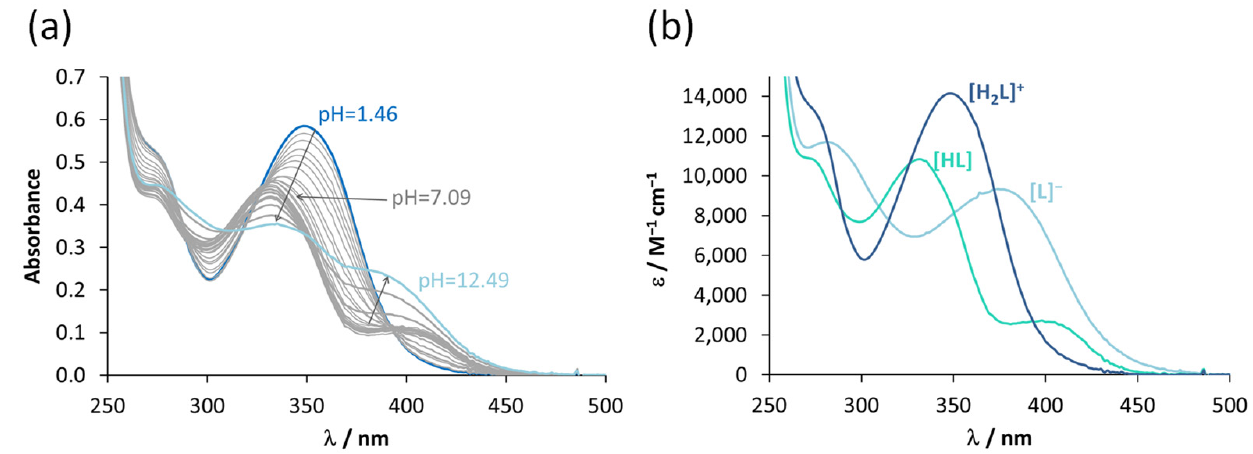
Figure 1. ( a ) UV - vis spectra of COTI-NMeCy recorded at various pH values, and ( b ) calculated individual molar absorption spectra for the species in the different protonation states. c compound = 20 µM; pH = 1.5 ‒ 12.5; T = 25 °C; I = 0.10 M (KCl); ℓ = 1.0 cm; and 30% ( v / v ) DMSO/H 2 O.